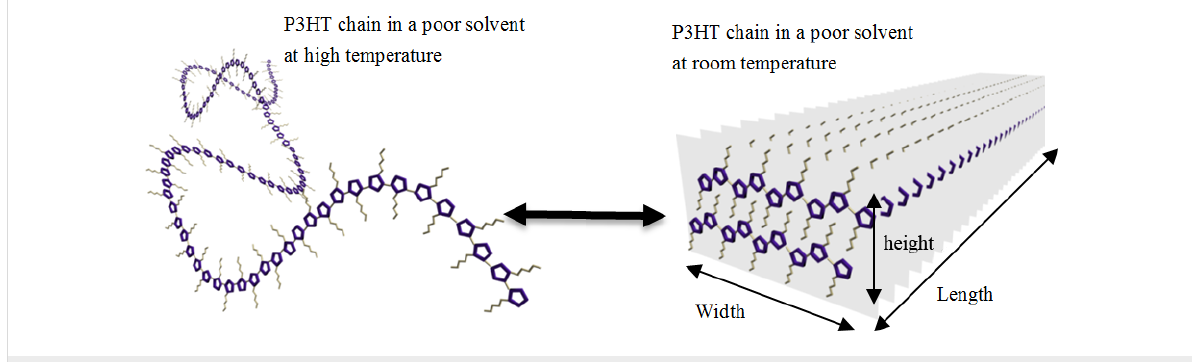
Figure 20: Schematic illustration of reversible formation of P3HT nanofiber.